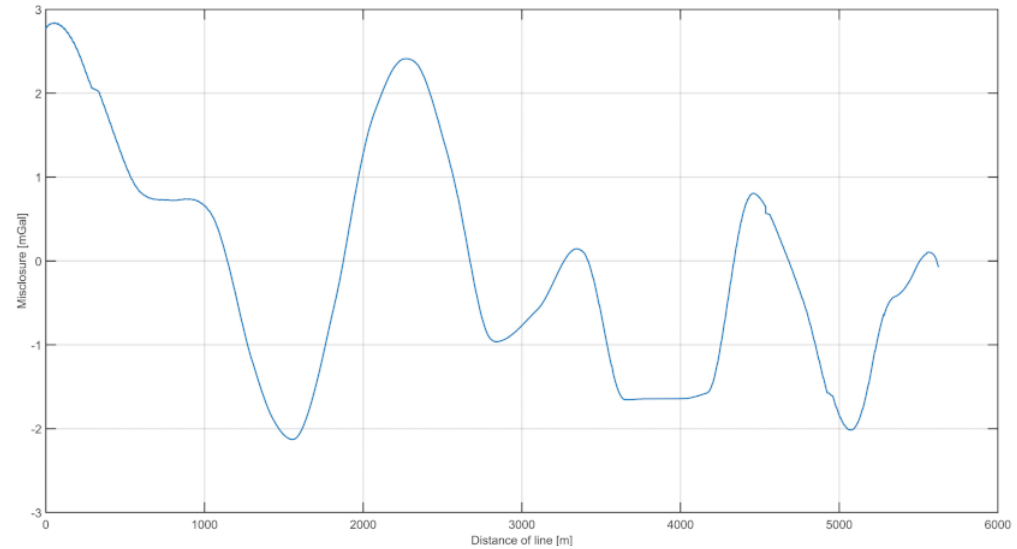
Figure 9. The distribution of di ff erences in the values of gravitational acceleration between the survey